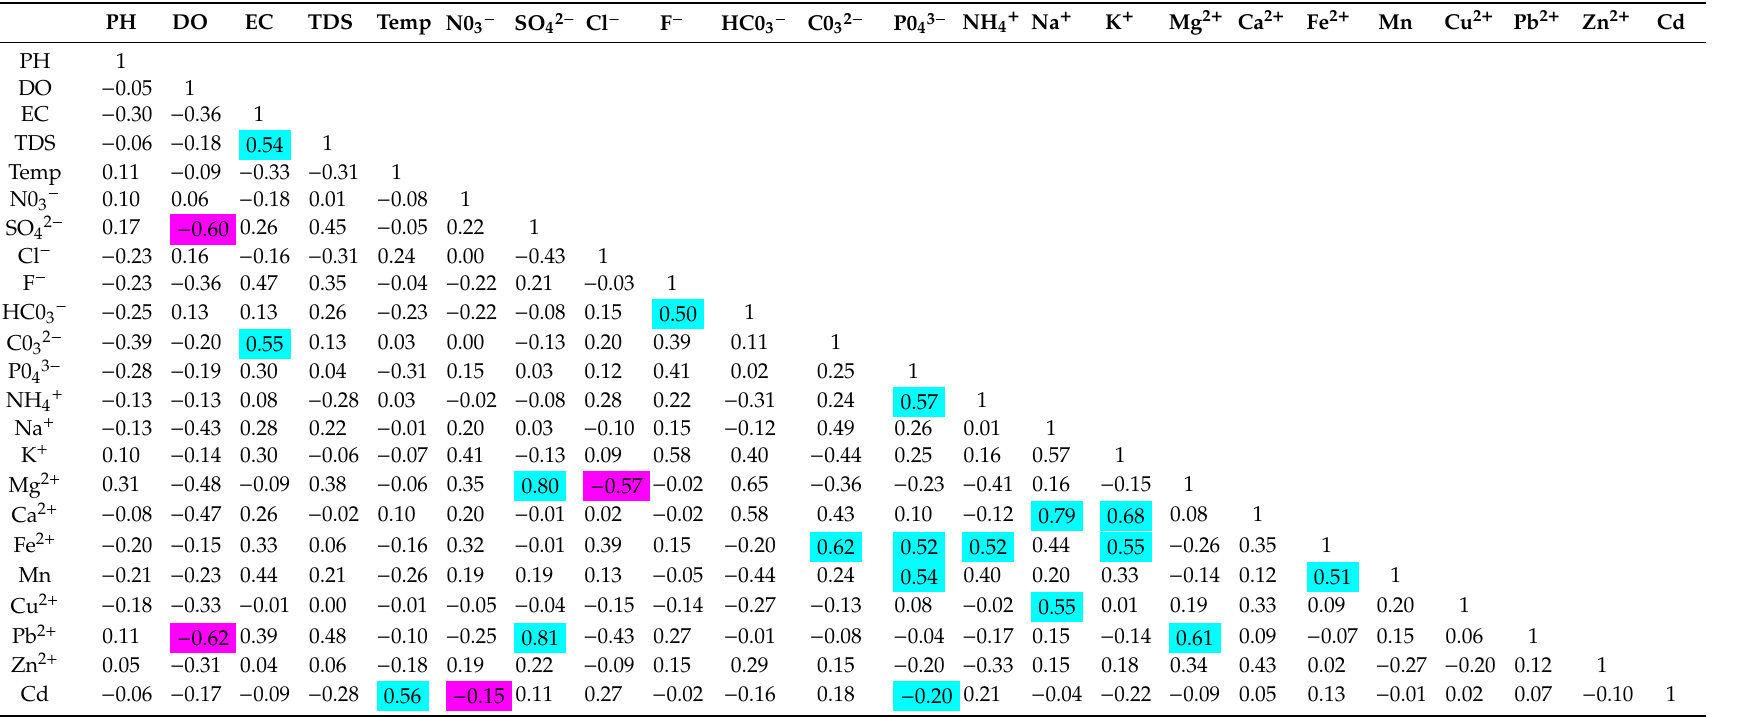
Table A4. Pearson correlation matrix of groundwater for the dry